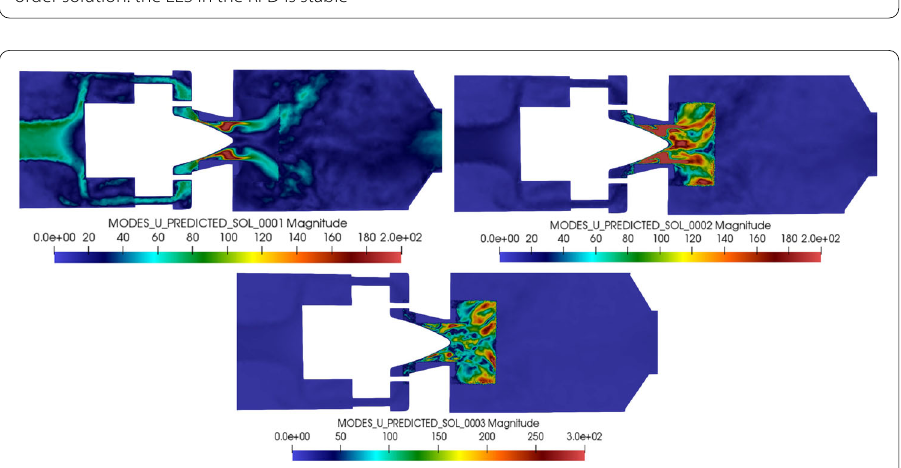
Fig. 27 Locally updated velocity modes (cid:9) 1 , (cid:9) 2 , (cid:9) 3 , with respect to the HF solution in the RFD associated with the first configuration. The first two modes are of global support (cid:2) and starting from the third mode, they all have a local support (cid:2)